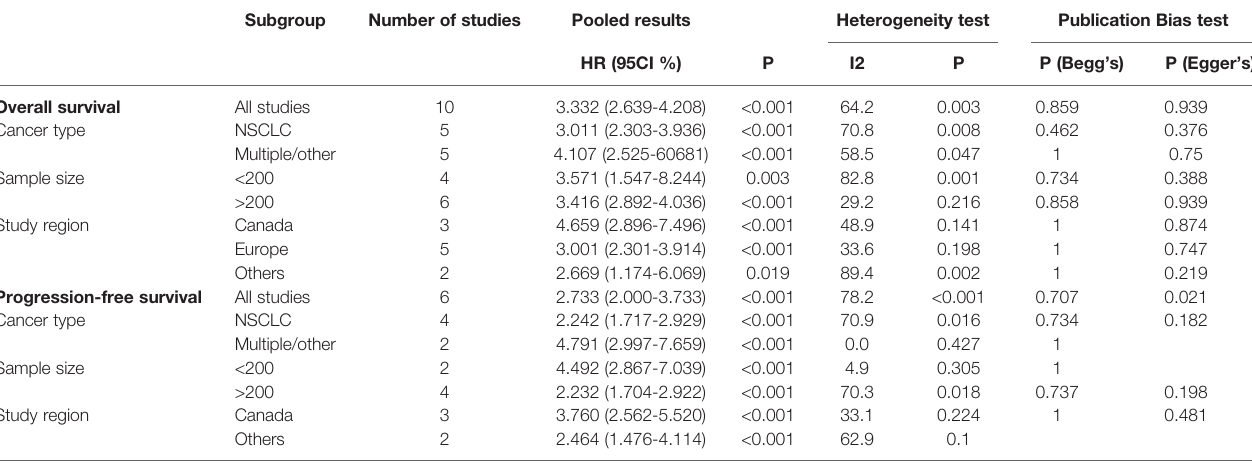
TABLE 2 | Subgroup analyses of the associations between LIPI score and outcomes (poor vs. good). Subgroup Number of studies Pooled results Heterogeneity test Publication Bias test